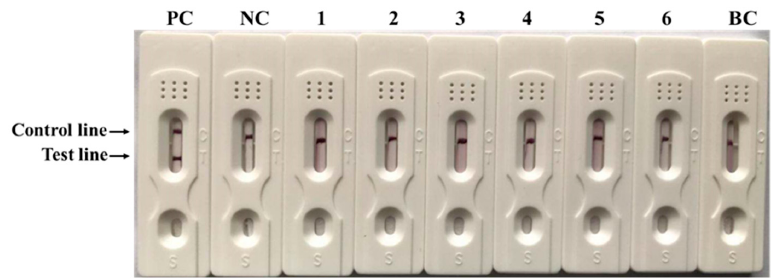
Figure 3. Specificity assay of RPA-LFD: PC, positive control, transgenic goat DNA; NC, negative control, non-transgenic goat DNA; lines 1–6 represent DNA of non-transgenic animals, namely, pigs, cattle, buffalo, sheep, chickens, and ducks, respectively; BC, blank control, water.